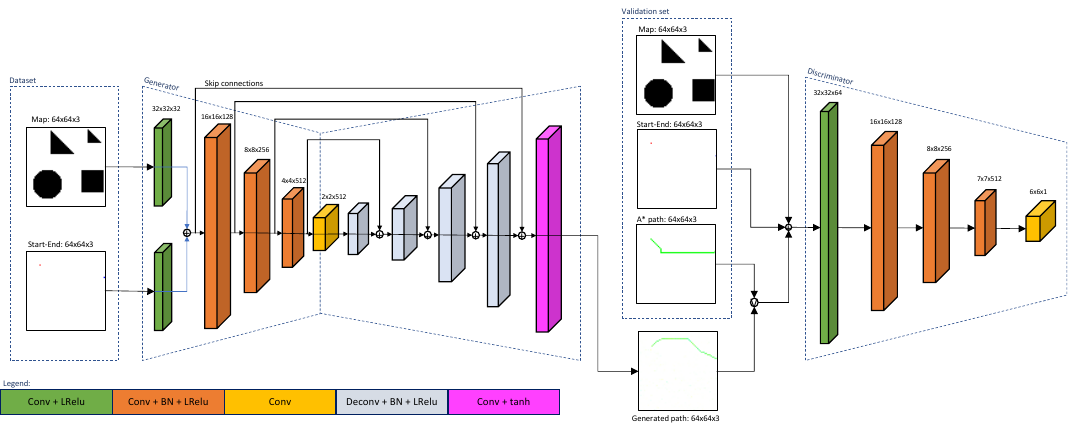
Figure 5. High-level GAN architecture sketch. The number of layers in the generator changed throughout the experiments.